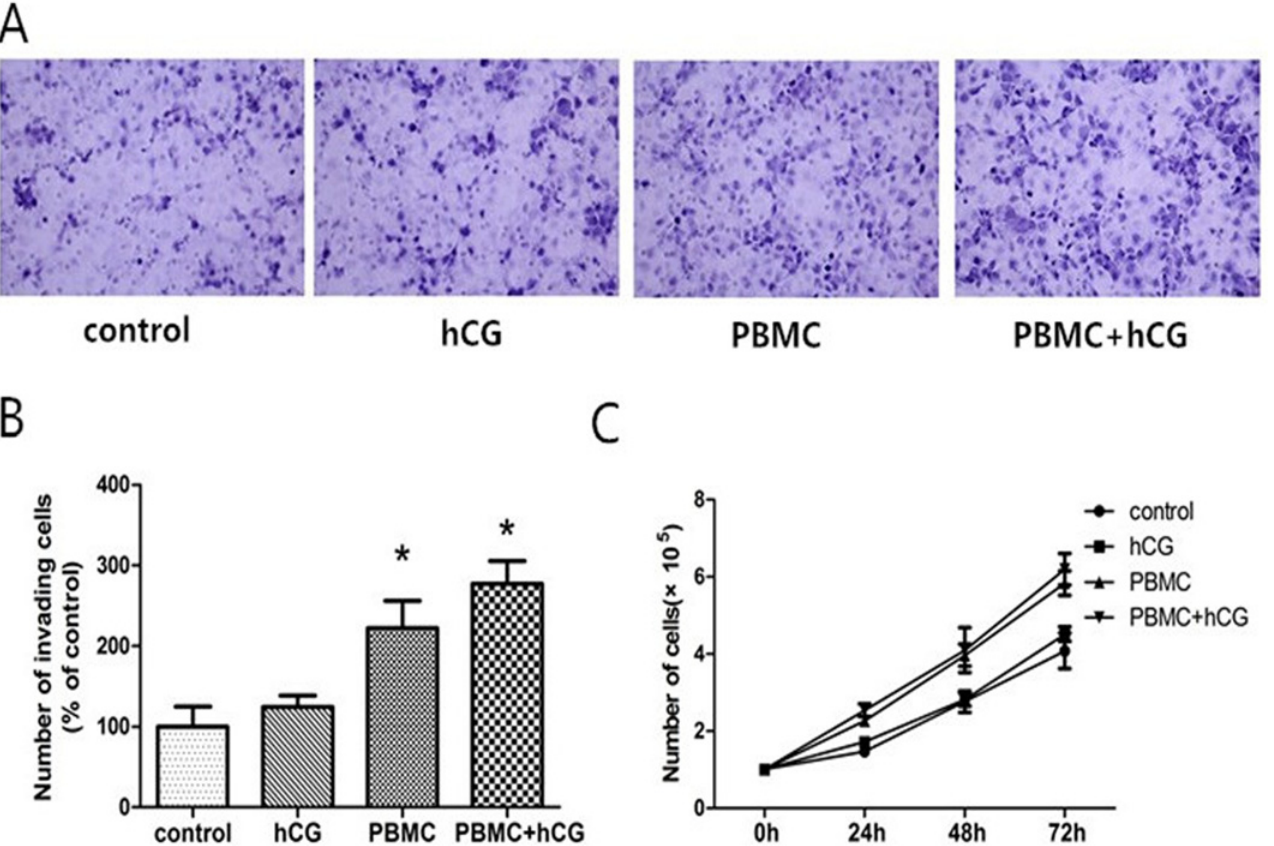
Fig 2. The effect of peripheral blood mononuclear cells (PBMC) activated by human chorionic gonadotropin (hCG) on JAR cell invasion and proliferation. (A) Invasion assays were of JAR cells resuspended in culture medium (control), 10 IU/mL hCG, PBMC, and PBMC with hCG, respectively. Representative microphotographs showing fixed and stained JAR cells on the bottom side of an invasion membrane from invasion assay. Magnification, ×400. (B) The invasion assay data are expressed as the mean fold change ± standard error of the mean of the number of invasive cells in each condition relative to the respective control. * P < 0.05. (C) Proliferation assay of JAR cells in the four groups over 3 culture days (P > 0.05).